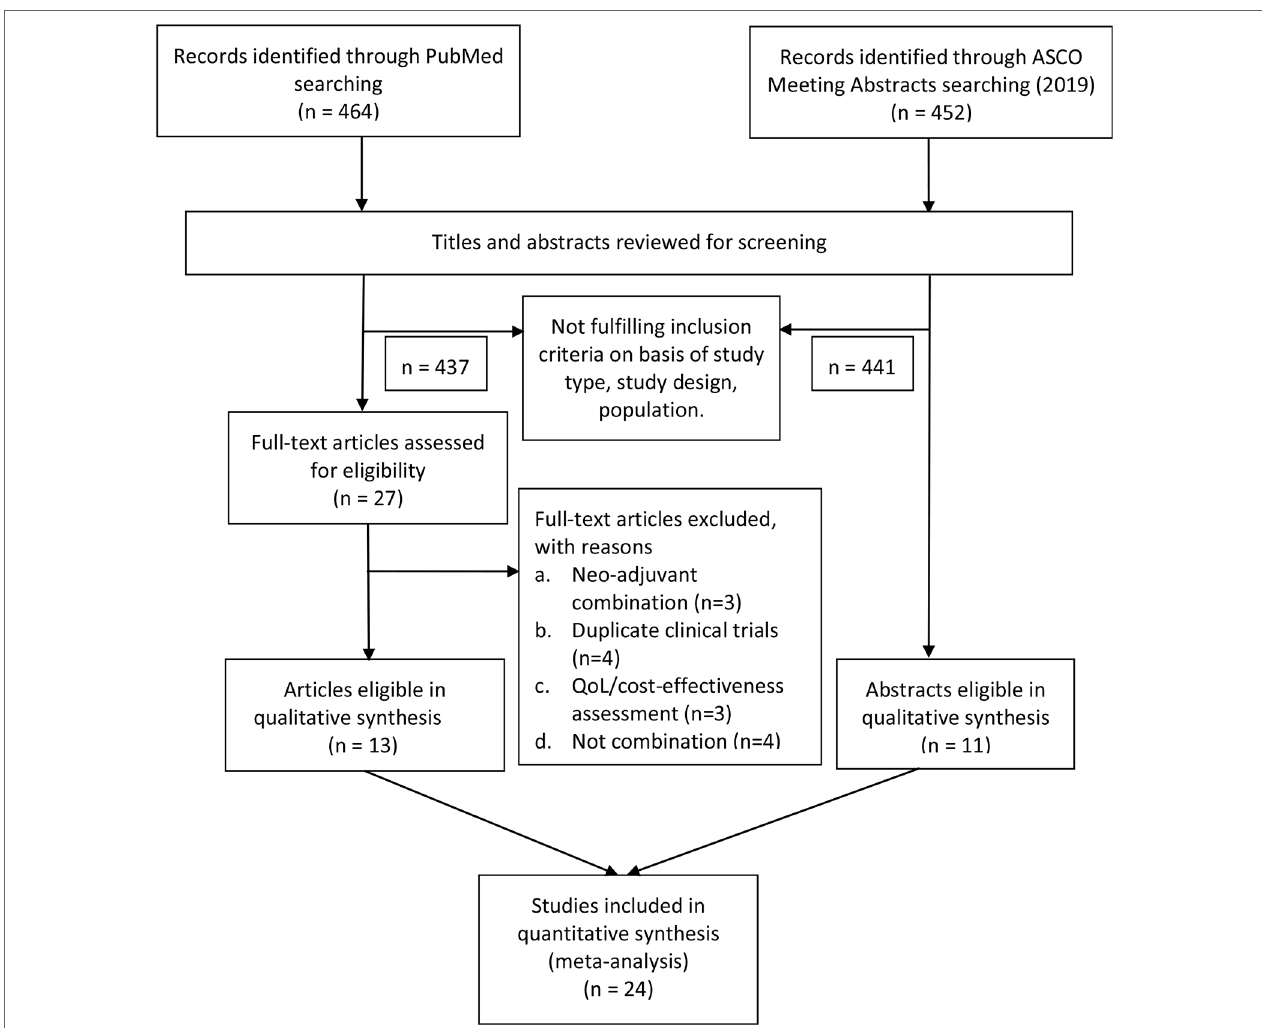
FIGURe 1 | Flow diagram of the eligible trials included in this study. ASCO, American Society of Clinical Oncology; QoL, quality of life.